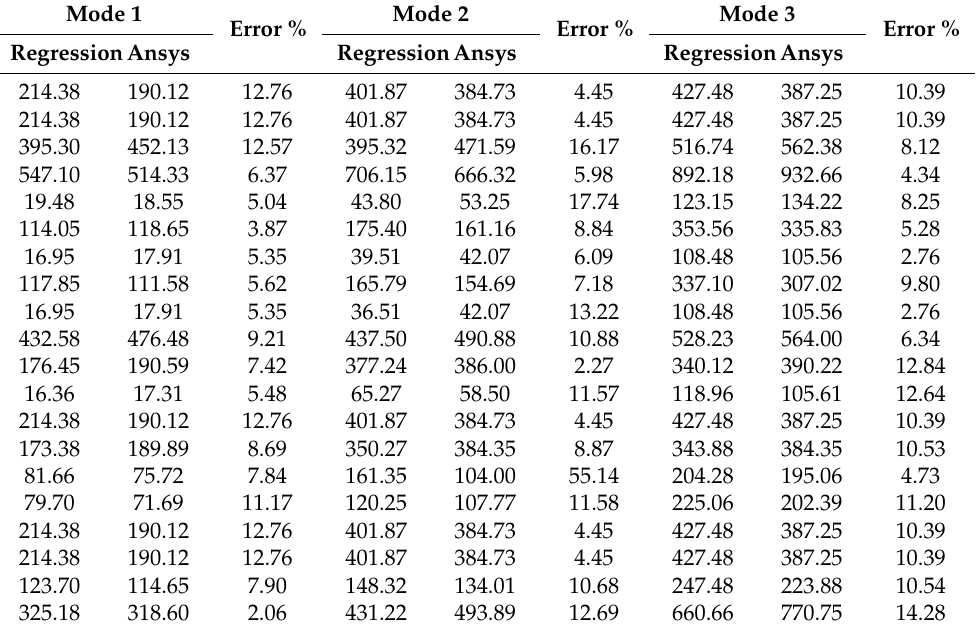
Table 9. Comparison of the natural frequencies obtained from the regression equations and finite element